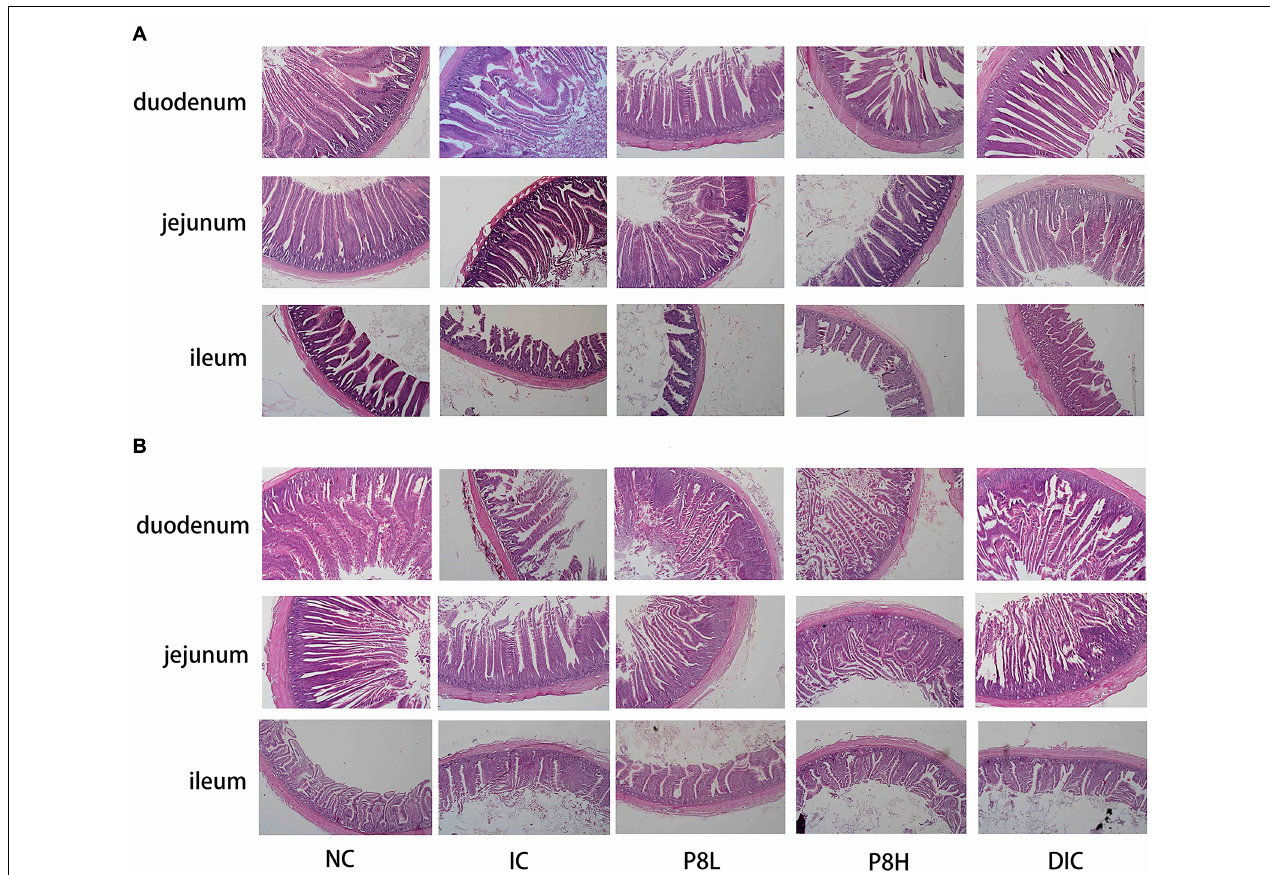
FIGURE 1 | Effects of P8 on the intestinal morphology of Eimeria -infected broilers. (A) Day 21, (B) day